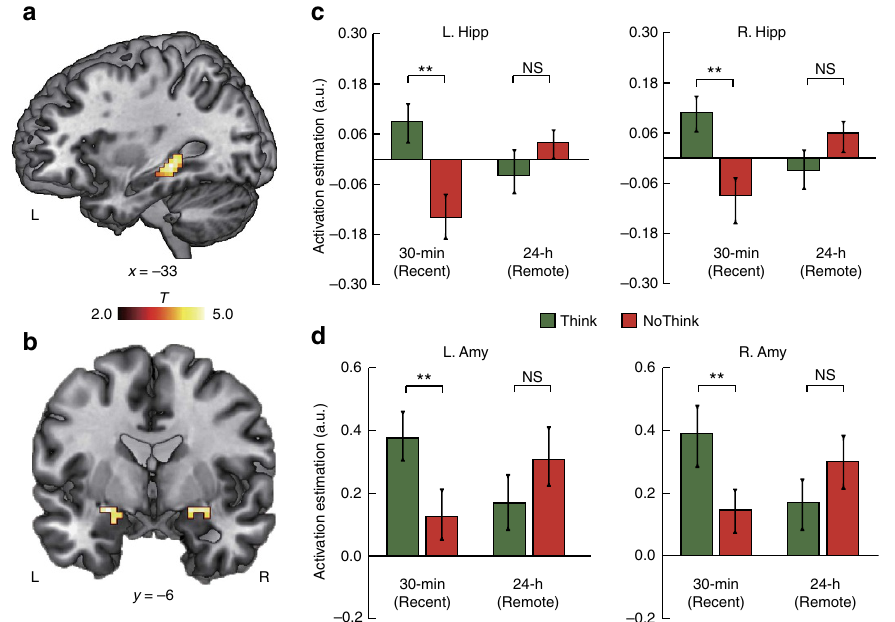
Figure 3 | Brain systems underlying memory suppression. ( a ) Sagittal view of significant clusters in the left hippocampus (MNI, peak at (cid:2) 33, (cid:2) 33 and (cid:2) 6), and ( b ) Coronal view of significant clusters in the left (MNI, peak at (cid:2) 24, 0 and (cid:2) 12) and right amygdala (MNI, peak at 21, 0 and (cid:2) 12) showing interaction effects between Suppression and Time (T_30min—NT_30min 4 T_24h—NT_24h). ( c , d ) Bar graphs represent functional activation in the hippocampus and amygdala. Each bar graph was plotted against the fixation period in the Think/NoThink task. Colour bar represents T values and error bars represent standard error of mean (s.e.m.). * P o 0.05; ** P o 0.01; Amy, amygdala; Hipp, hippocampus; L, left; MNI, Montreal Neurological Institute coordinate system; R,